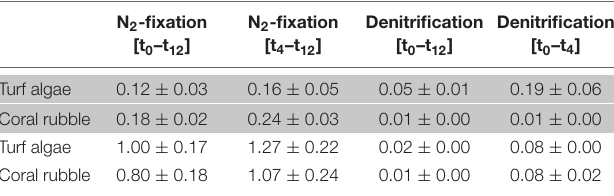
TABLE 1 | N 2 -fixation (nmol N 2 cm − 2 h − 1 ) and denitrification (nmol N 2 O cm − 2 h − 1 ) rates/potentials in turf algae and coral rubble. N 2 -fixation [t 0 –t 12 ]